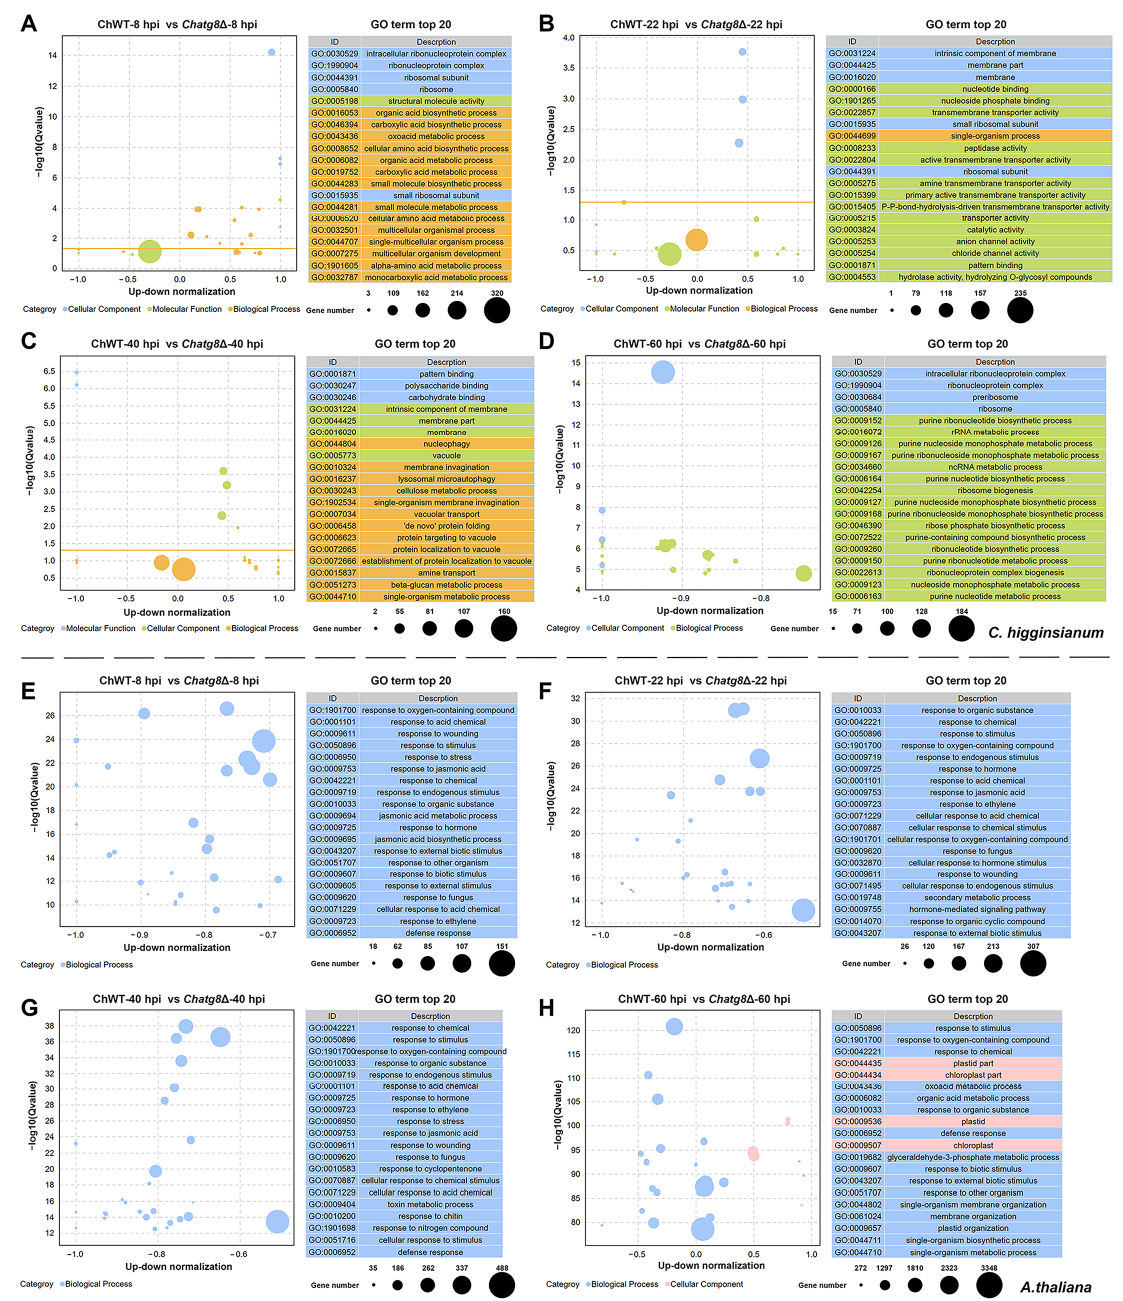
Figure 3. GO terms of the DEGs in the four comparison groups. ( A , E ) ChWT-8 hpi vs. Chatg8 Δ-8 hpi in C. higginsianum or A. thaliana . ( B , F ) ChWT-22 hpi vs. Chatg8 Δ-22 hpi in C. higginsianum or A. thaliana . ( C , G ) ChWT-40 hpi vs. Chatg8 Δ-40 hpi in C. higginsianum or A. thaliana . ( D , H ) ChWT-60 hpi vs. Chatg8 Δ-60 hpi in C. higginsianum or A. thaliana . The horizontal axes are up-down normalization and the vertical axes are −log10 (Qvalue). Up-down normalization refers to the proportion of the difference between the number of up-regulated genes and the number of down-regulated genes in the total number of differential genes, and the size of the dots refers to the number of DEGs in each GO term.